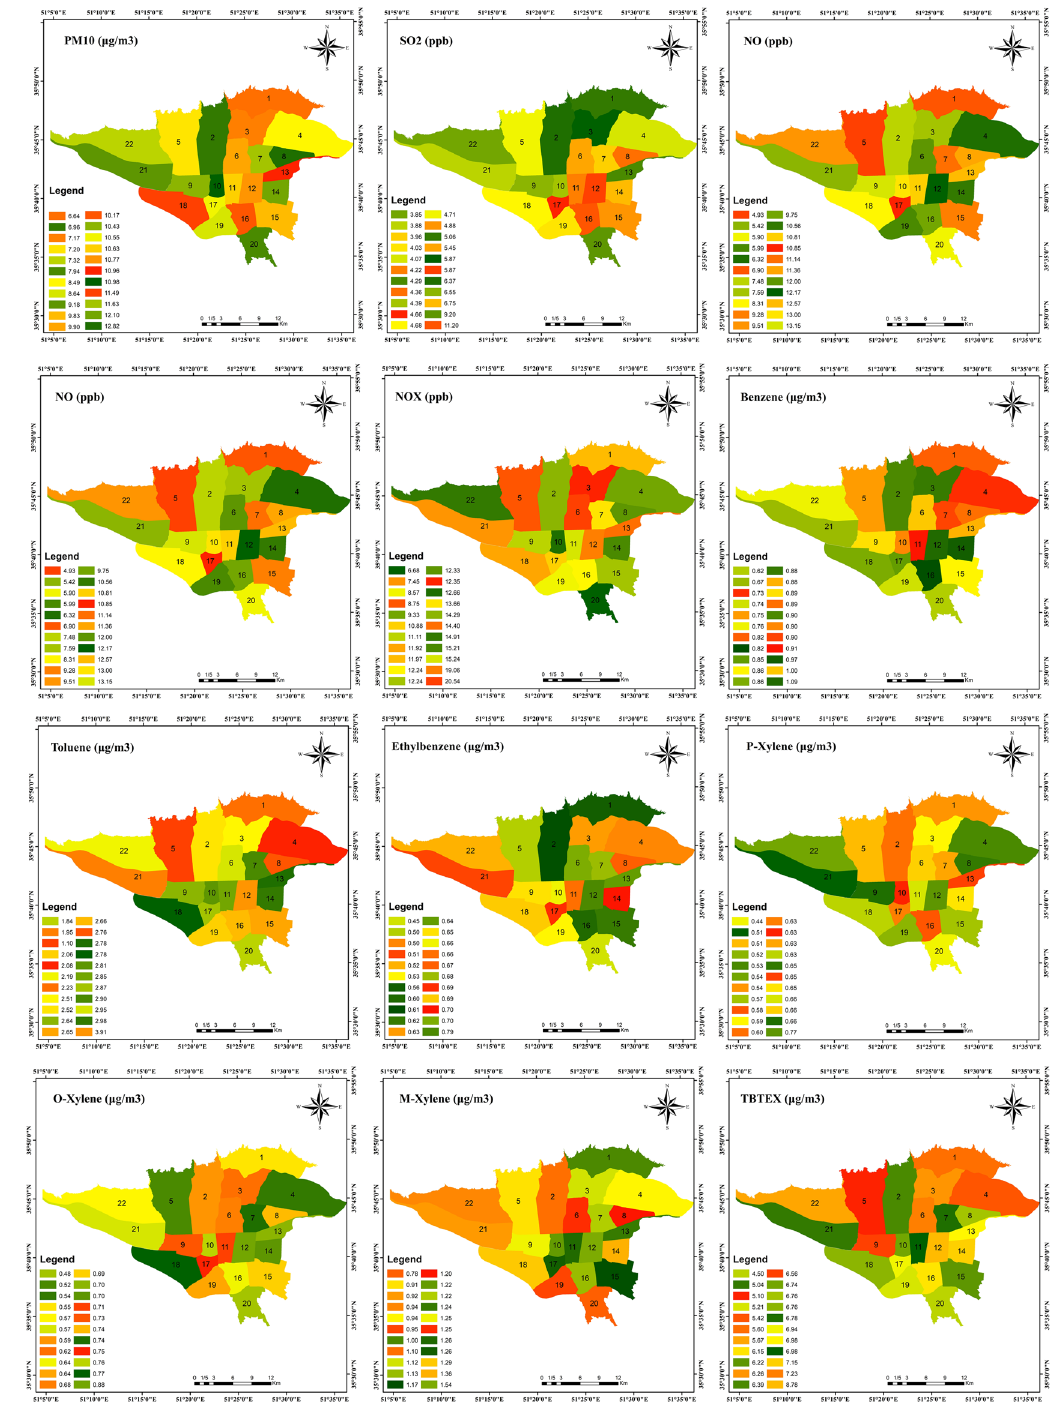
Figure 2. Spatial distribution and average levels of ambient air pollutants in different areas of Tehran in